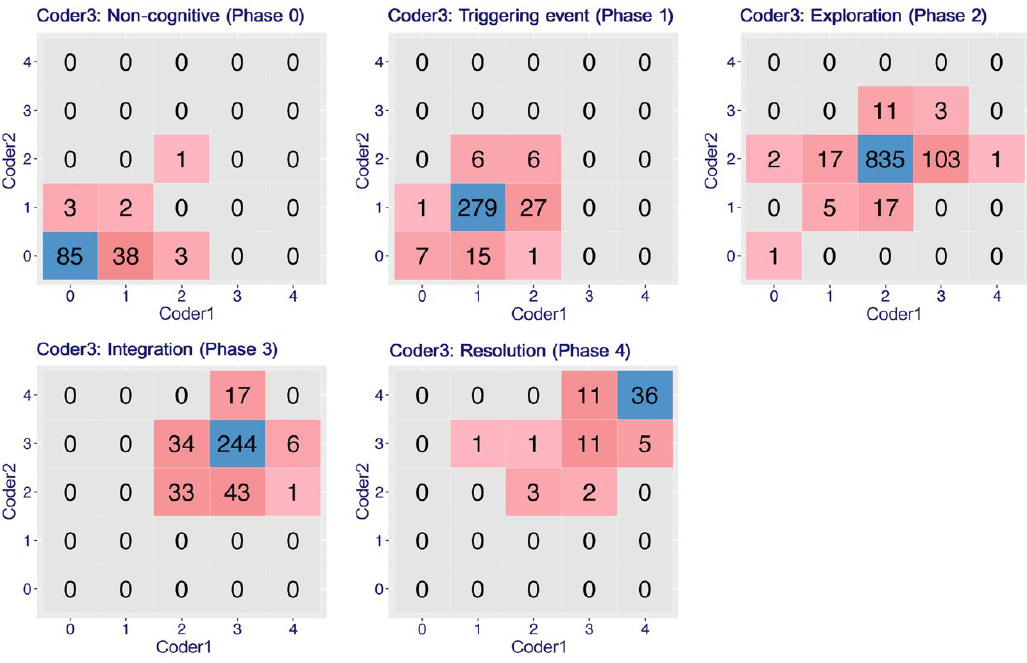
Distribution of Five Cognitive Phases Between Three Coders